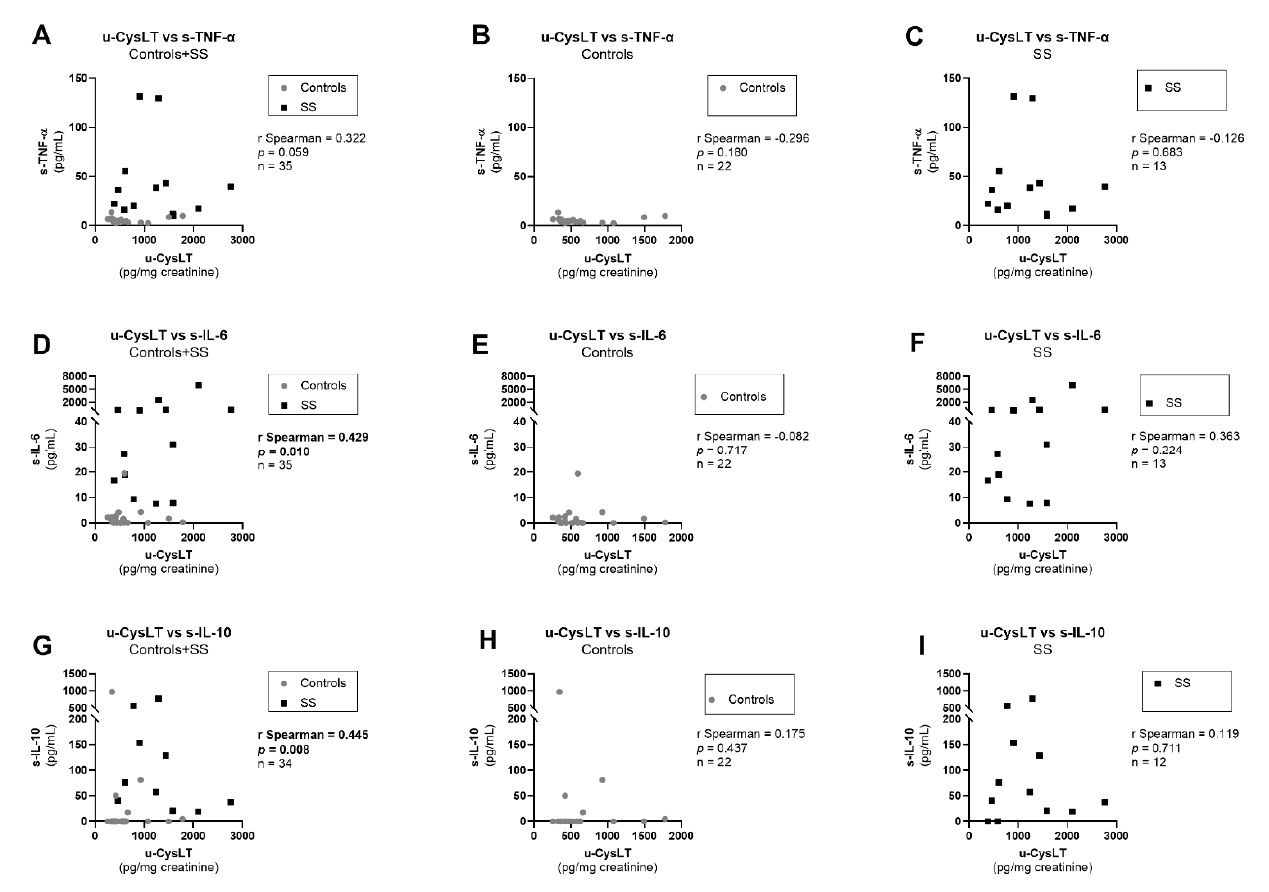
u-CysLT vs. lymphocytes (r Spearman = − 0.203, p = 0.505, n = 13), u-CysLT vs. monocytes (r Spearman = − 0.369, p = 0.214, n = 13), and u-CysLT vs. NLR (r Spearman = 0.484, p = 0.097, n = 13).